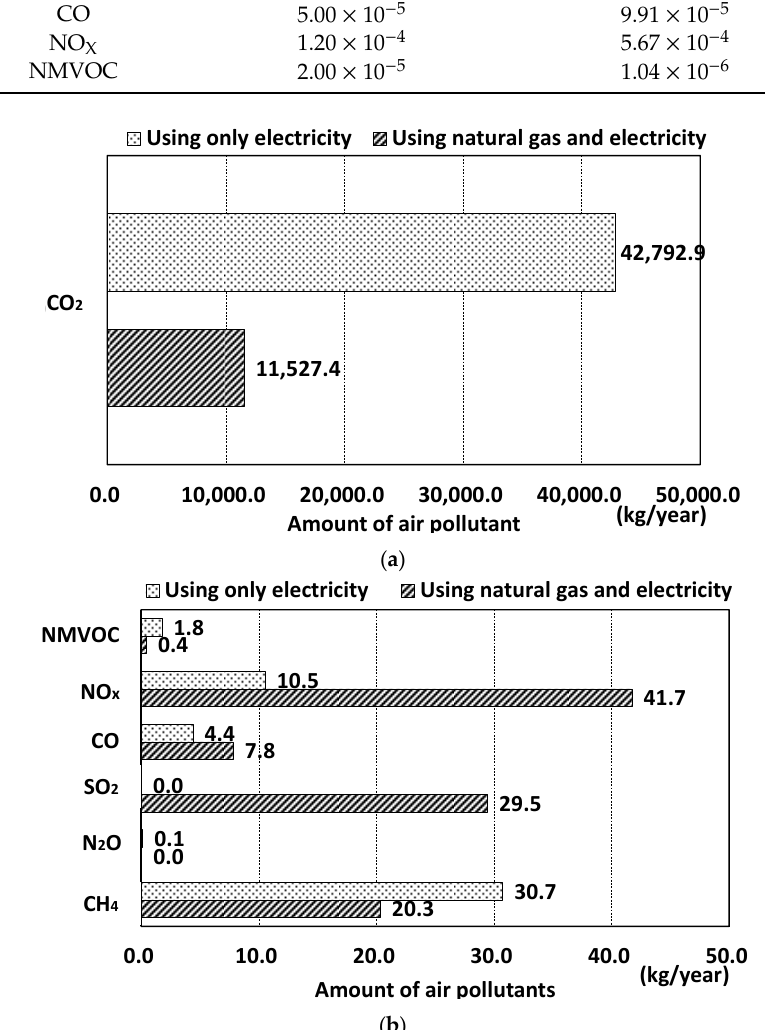
Figure 3. Comparison of air pollutant amounts between the building using only electricity and the building using electricity and natural gas together. ( a ) Comparison of amount of CO 2 emission ( b ) Comparison of amount of other air pollutants emission.